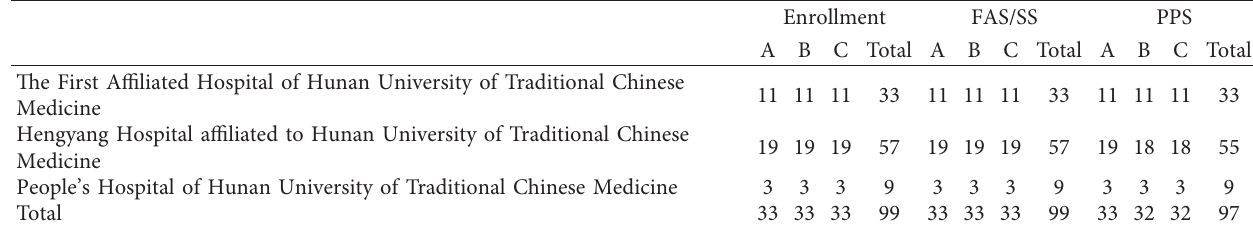
Table 1: Pathological